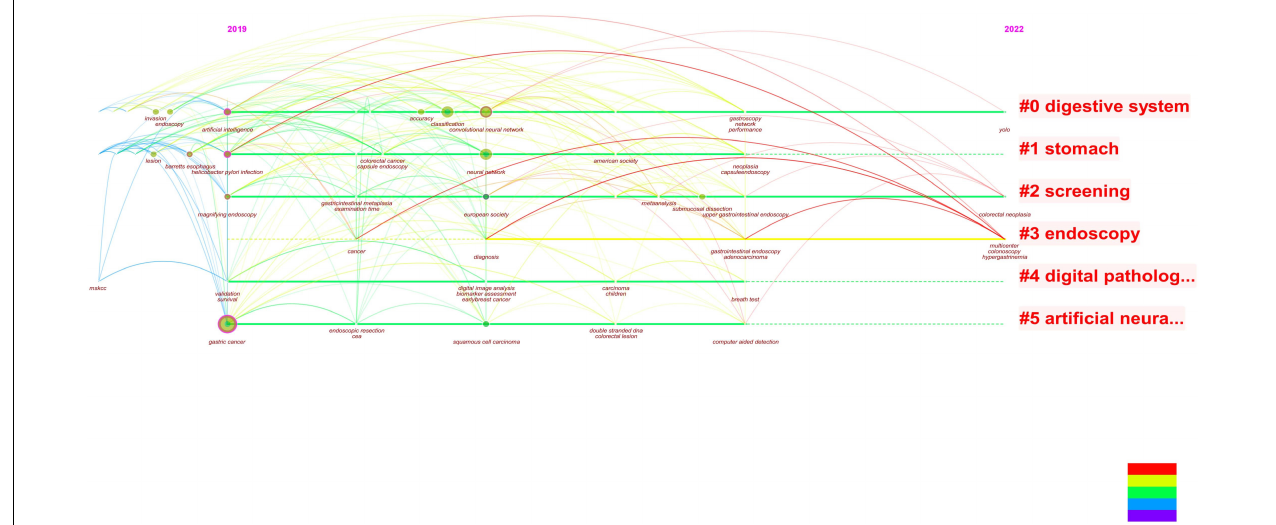
FIGURE 6 | By analyzing the figure, it can be seen that when combined with literature on early gastric cancer and artificial intelligence, both of these topics have occurred in recent years. Additionally, this year’s study focused on endoscopic screening.